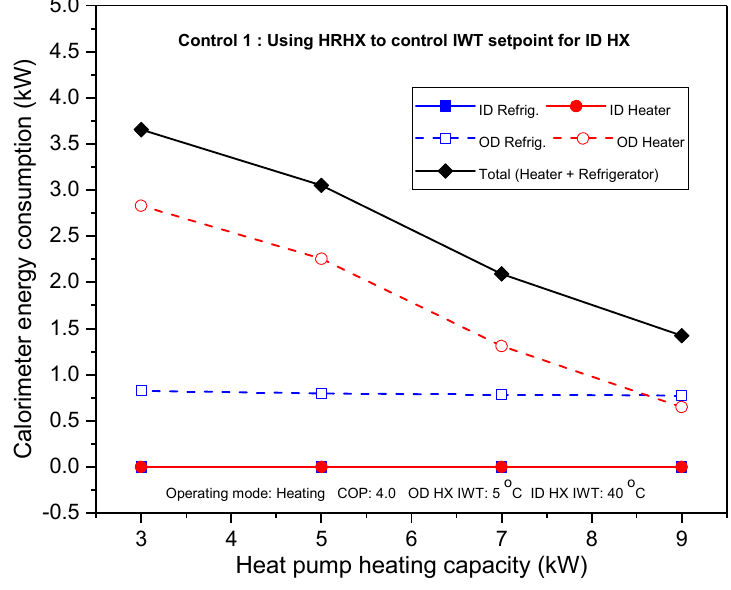
Figure 4. Calorimeter energy analysis with variation in heat pump heating capacity for control (1).